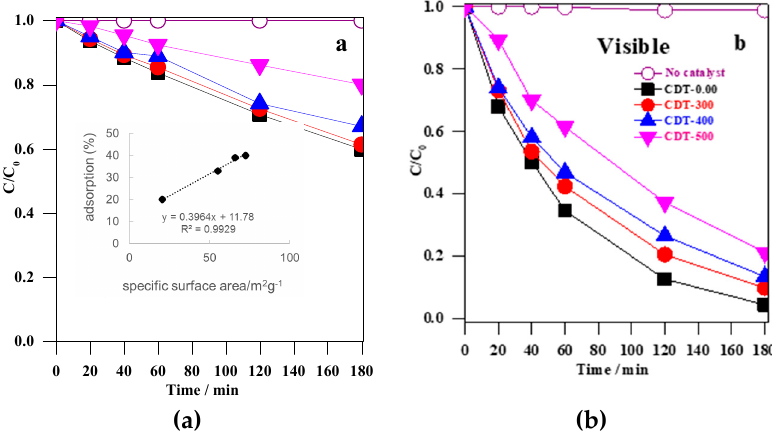
Figure 8. Change of the MC-LR concentration with initial concentration 10 mg L − 1 versus reaction time: ( a ) under dark condition; and ( b ) under visible light illumination for 3 h using CDT-0.00, CDT-300,